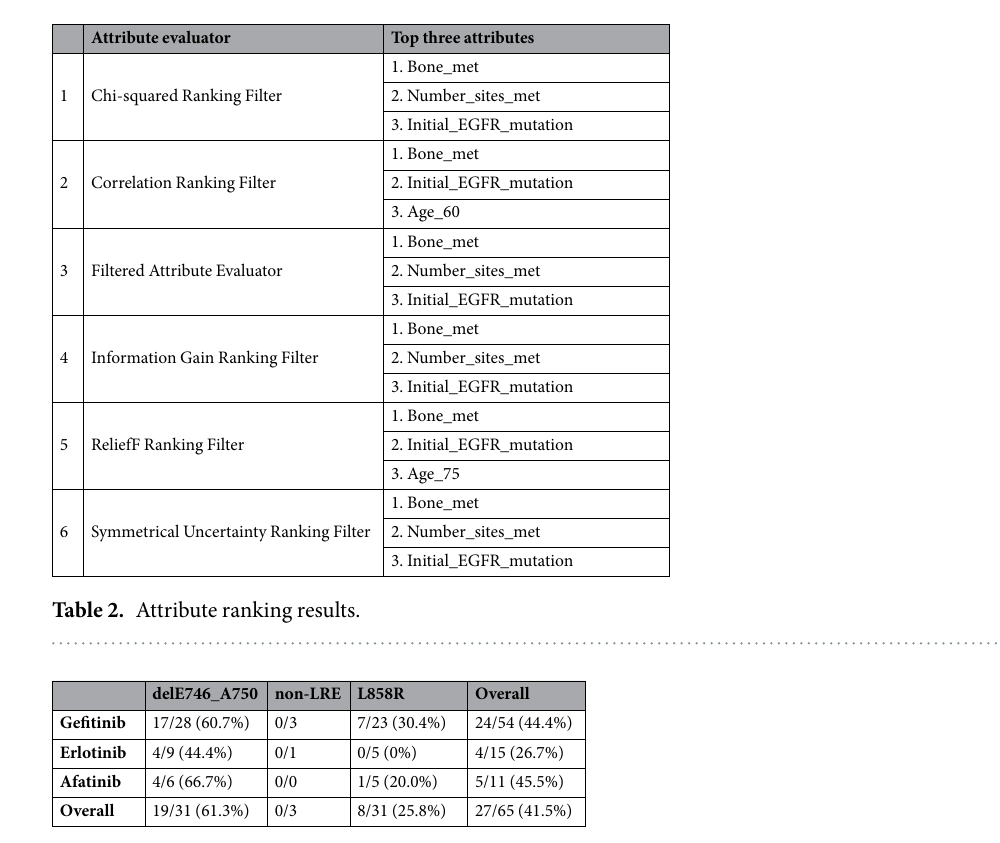
Table 3. Probability of acquiring T790M for each mutation and tyrosine-kinase